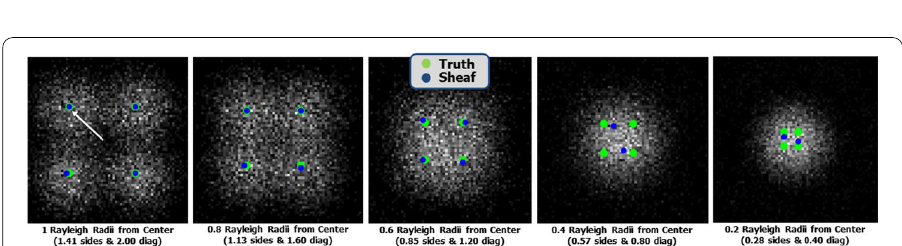
Fig. 6 Photon count distributions for four stars (green) at various inter-star separations, with the minimizers of consistency radius for the J 15 sheaf superimposed (blue) and ten thousand (10,000) total photons. (Star count unknown but less than